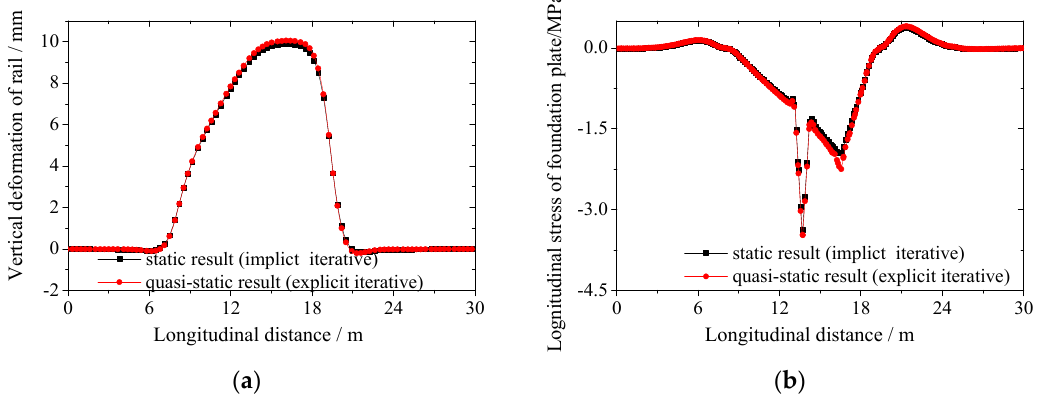
Figure 8. Comparison between the static and quasi-static results. ( a ) Vertical deformation of rail; ( b ) Longitudinal stress of foundation plate.